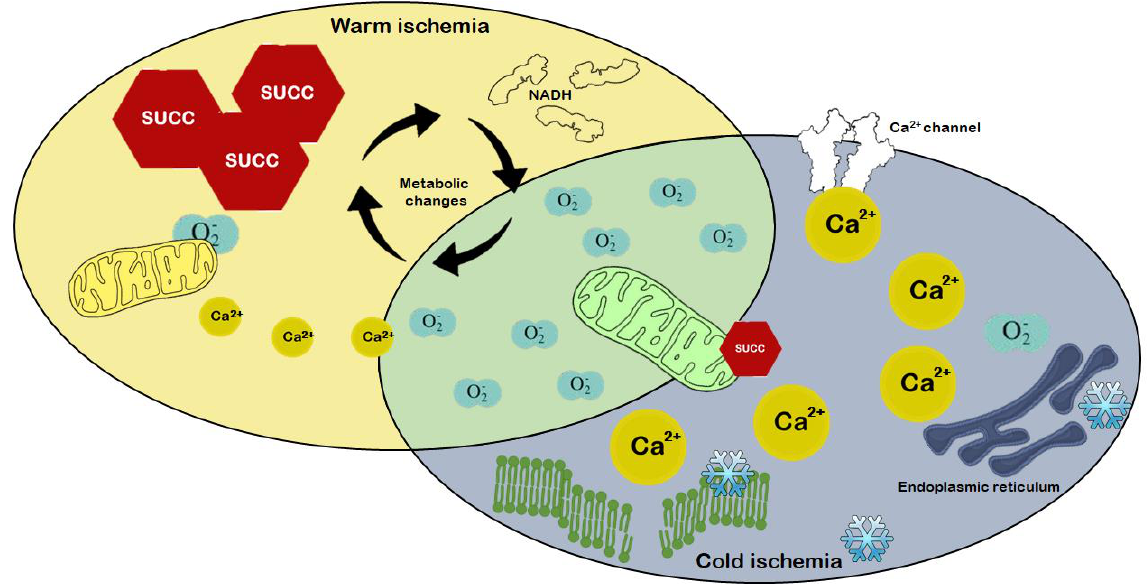
Figure 8 . Intracellular changes in warm and cold ischemia. Warm ischemia is mainly characterized by an accumulation of succinate and NADH, while an increase in Ca 2+ levels is more prominent in cold ischemia. Mitochondrial ATP depletion is more significant in warm ischemia, causing severe metabolic changes. Production of reactive oxygen species can be observed in both types of ischemia.